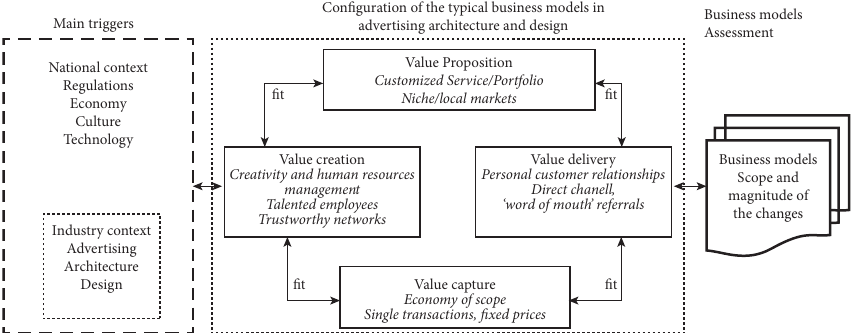
Figure 1. Conceptual framework for business model (BM) analysis (source: created by